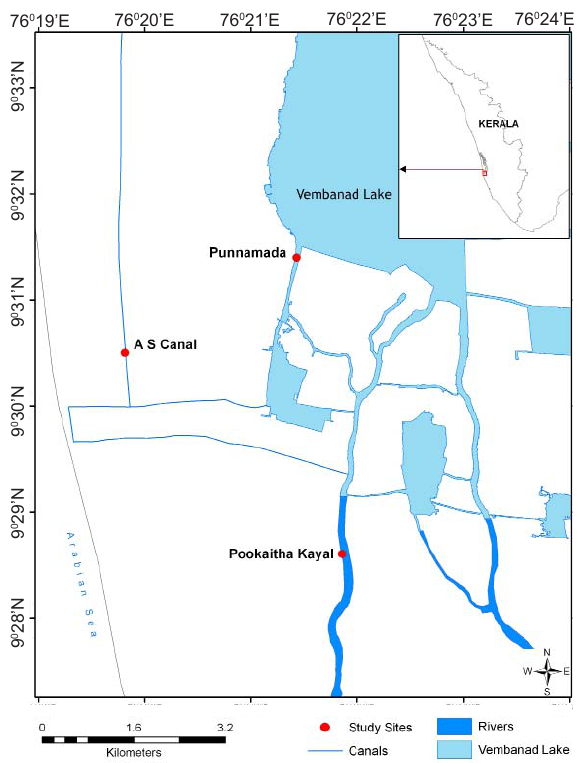
Figure 1. Map of Vembanad Lake showing sampling